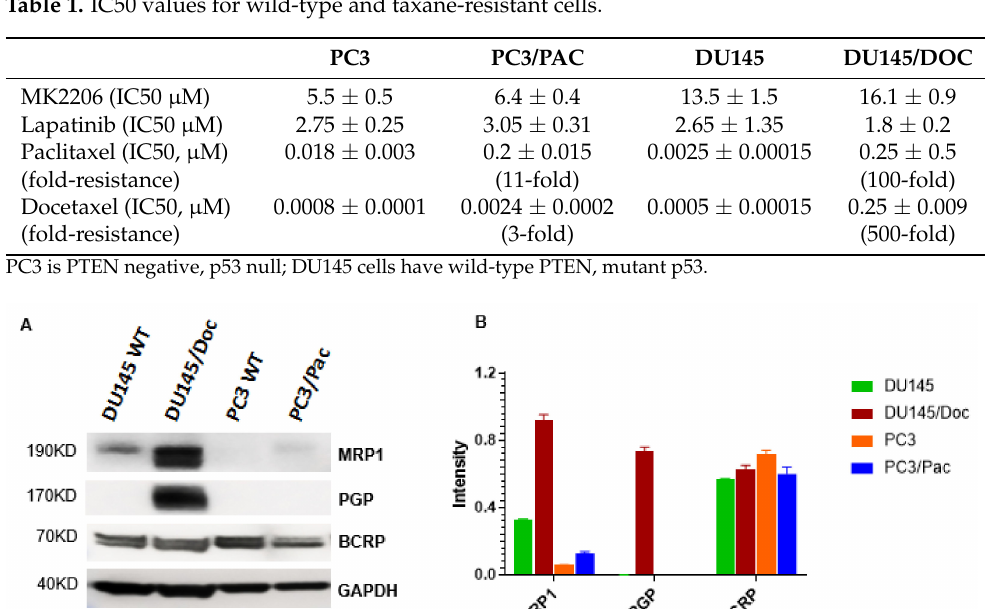
Table 1. IC50 values for wild-type and taxane-resistant cells.